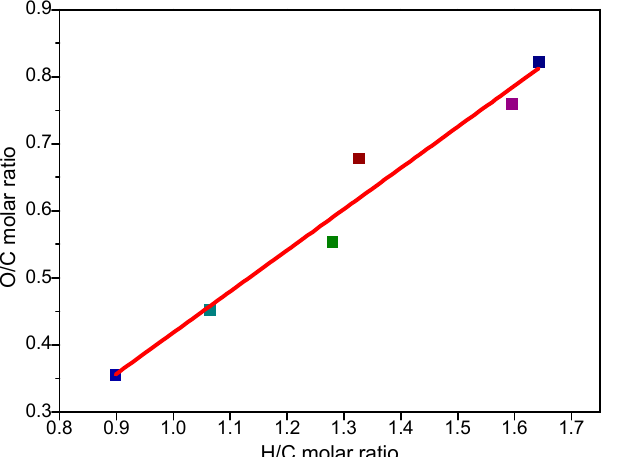
Figure 2. The O/C molar ratio of raw and torrefied corn cobs as a function of the H/C molar ratio.